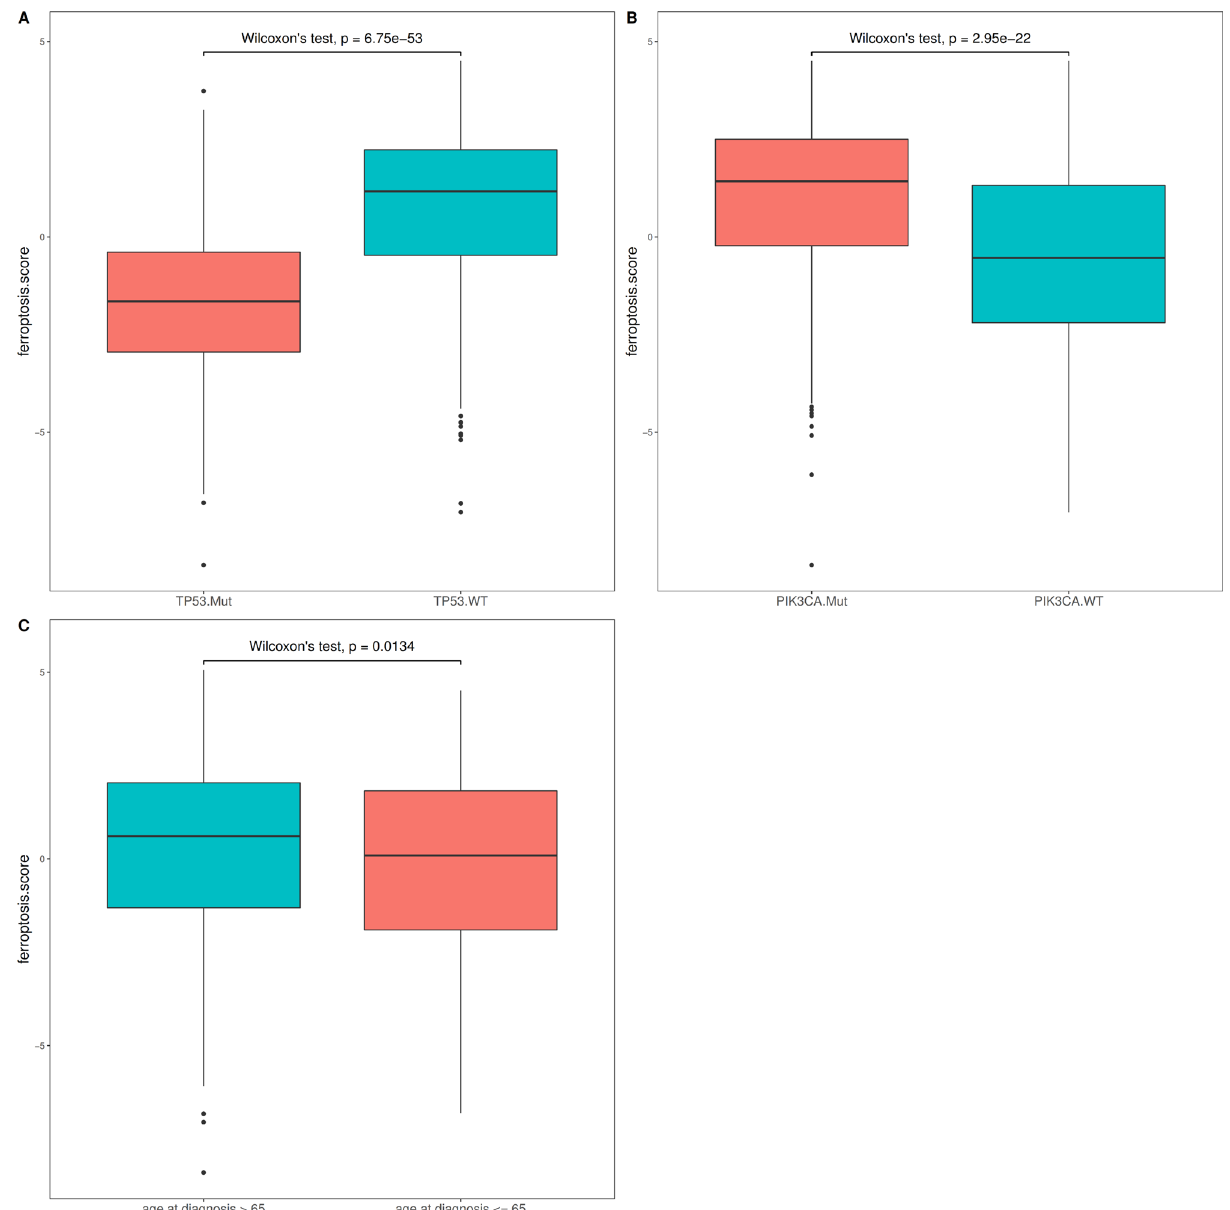
Figure 9. Comparative analysis of ferroptosis scores in different molecular subtypes and clinical characteristics ( A : TP53 mutation; B : PIK3CA mutation, C :